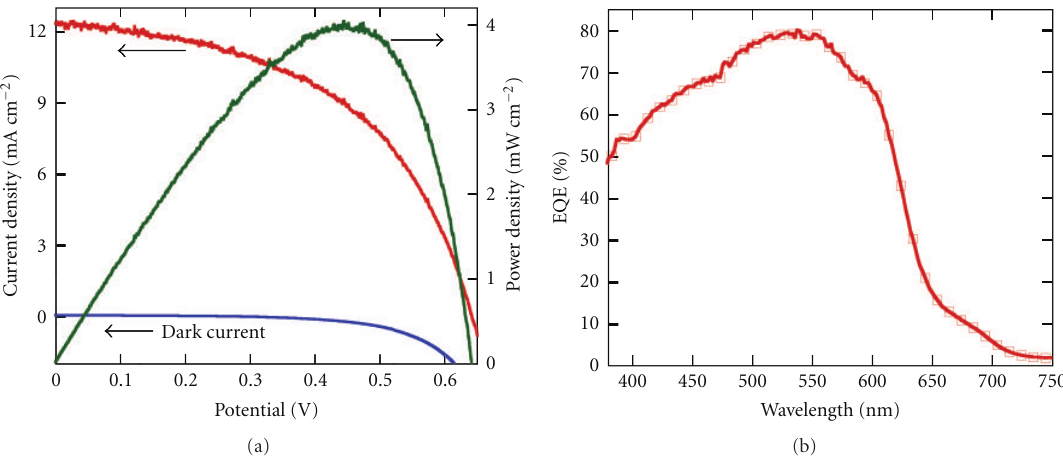
Figure 4: (a) J - V characteristics of TiO 2 nanotube array-polymer bulk heterojunction solar cells showing the dark current, photocurrent, and power density under 1 sun AM 1.5 illumination. (b) EQE of the nanotube array-polymer bulk heterojunction solar cells. Reprinted with permission from